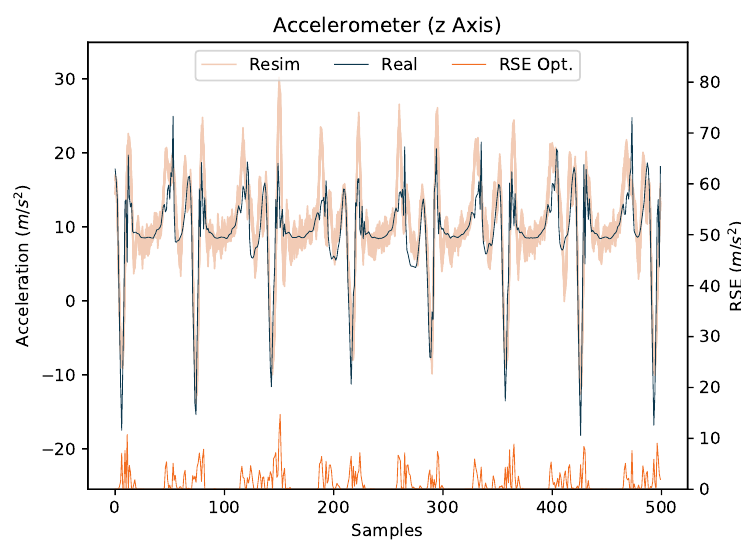
Figure 7. Figure 6 augmented with 100 noisy re-simulated signals per timestep and the respective root squared errors (RSE) between the real signal and the closest re-simulated signal at each timestep (RSE